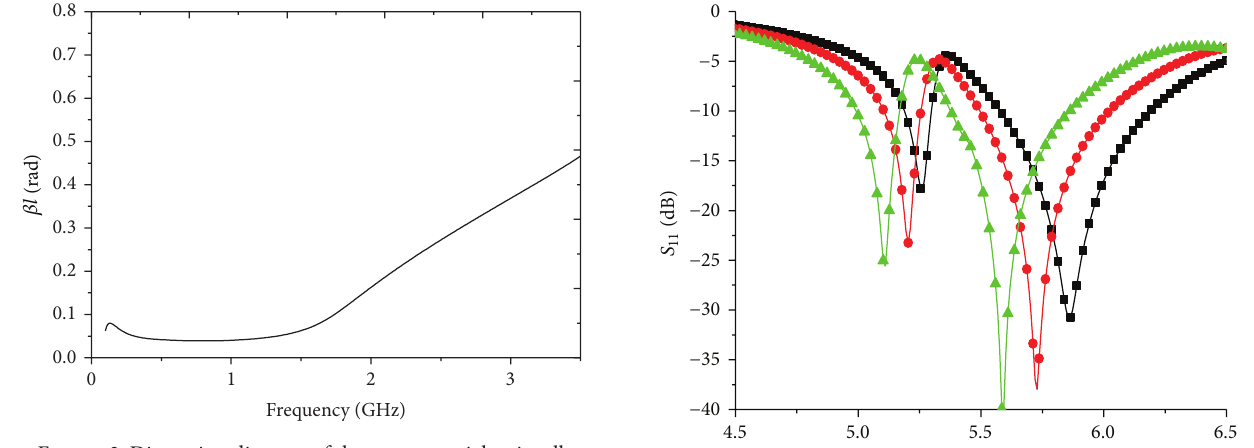
Figure 3: Dispersion diagram of the metamaterial unit cell.